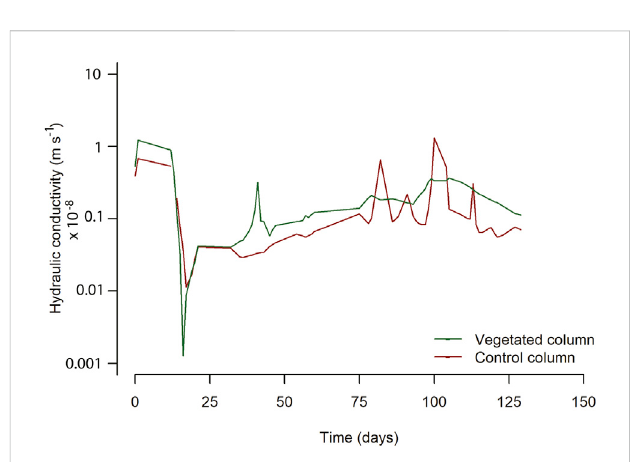
FIGURE 6 Depth-averaged conductivity for the control and vegetated